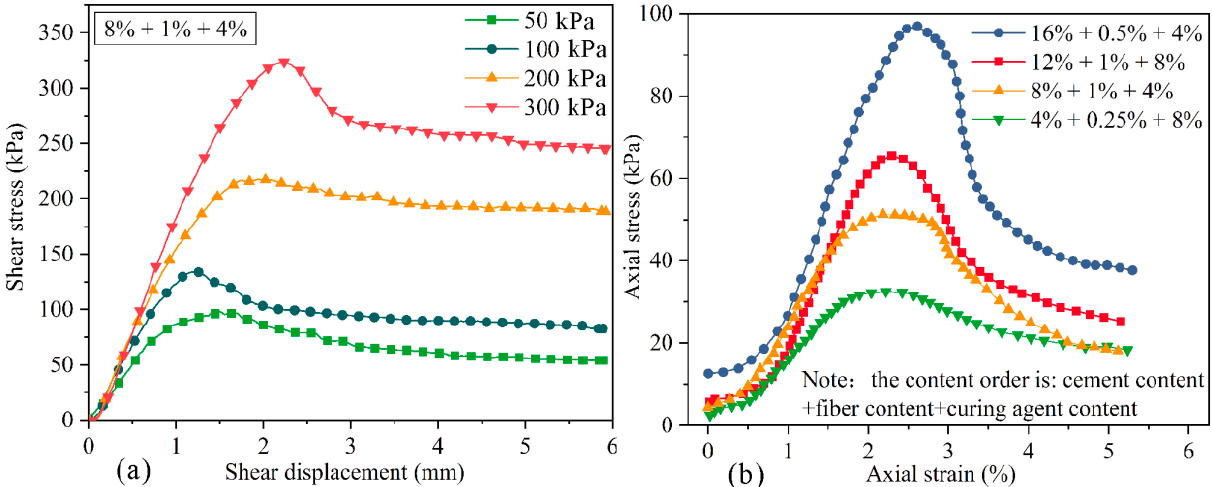
Figure 5. Test results of some samples: ( a ) shear stress–shear displacement curve of direct shear tests; ( b ) axial stress–strain curve of unconfined compressive tests.